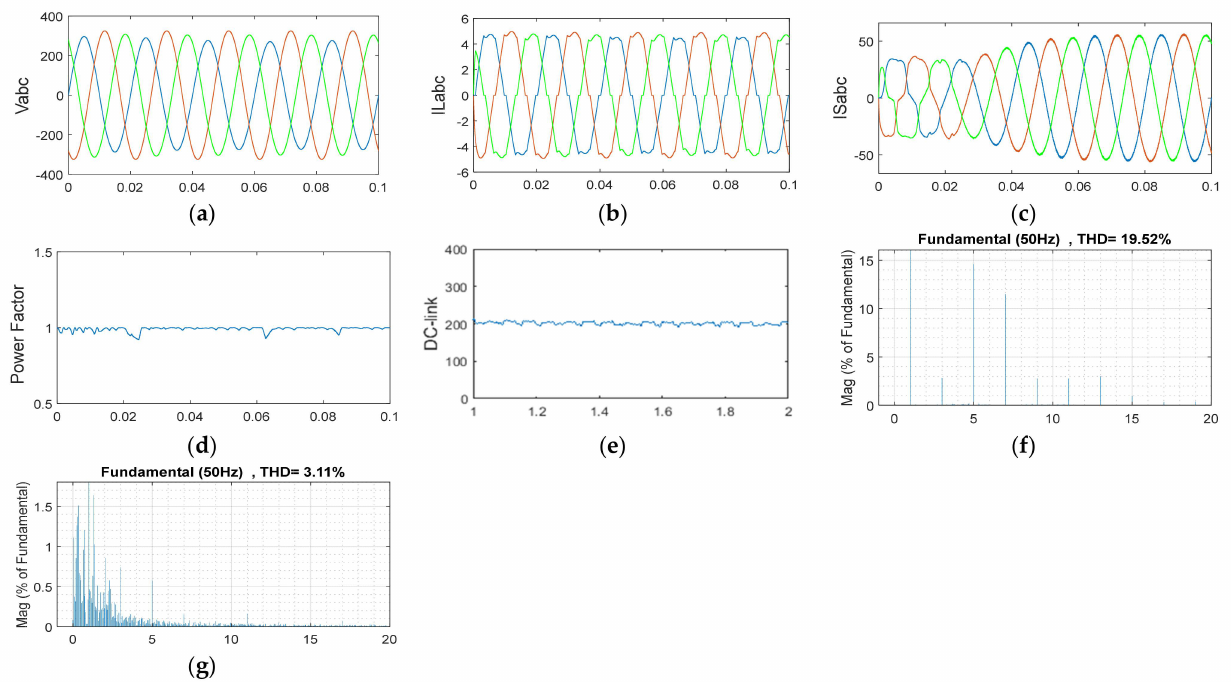
Figure 9. The simulation results of the proposed algorithm in Section 3.2: ( a ) Unbalanced and sinusoidal 3-phase voltage source; ( b ) 3-phase source current before mitigation; ( c ) 3-phase source current after mitigation; ( d ) power factor; ( e ) DC-link voltage; ( f ) THD for load current; ( g ) THD for line